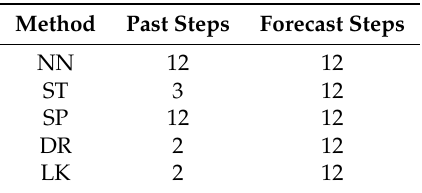
Table 3. Comparison of the number of images processed by the different methodologies to obtain a forecast of 12 steps, equivalent to 1